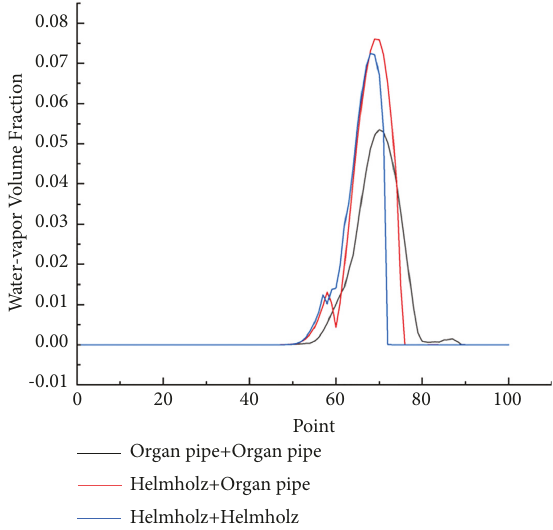
Figure 9: Water vapor phase volume fraction distribution of different dual-chamber self-excited oscillating pulsed